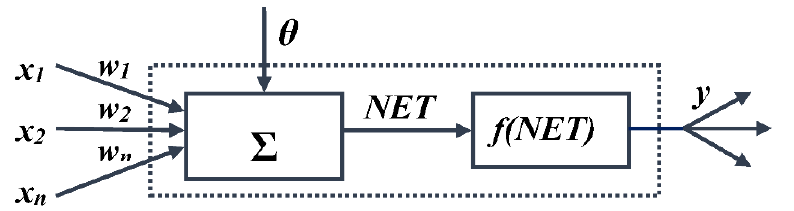
Figure 5. Model of a formal neuron.